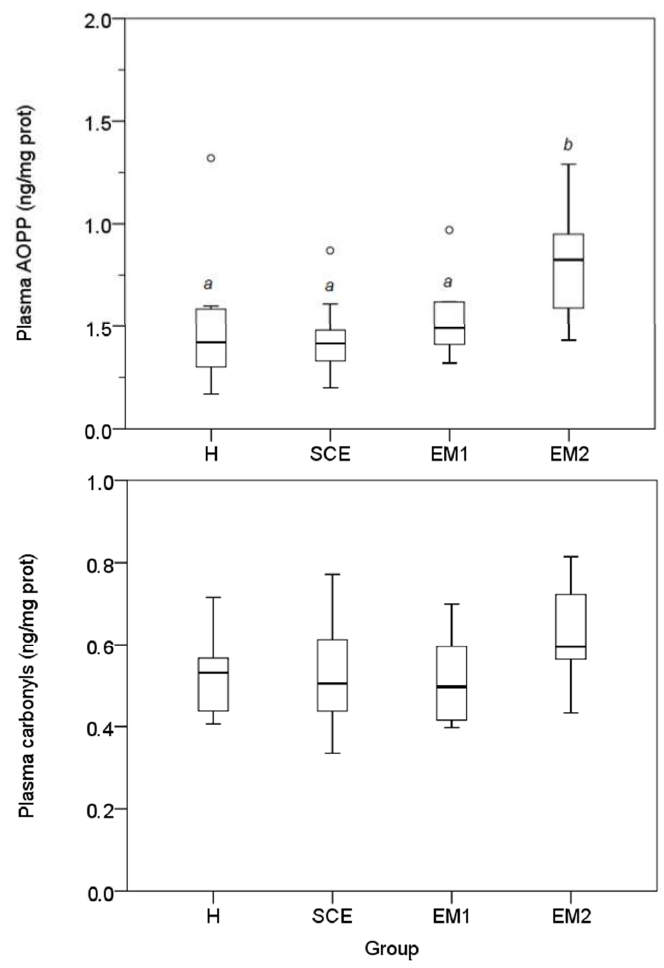
Figure 1. Plasma AOPP and carbonyl group concentrations in the four groups of cows. Different superscripts ( a,b ) indicate statistically significant differences ( p < 0.05; Kruskal-Wallis one-way ANOVA and pairwise multiple comparisons, SPSS 24.0). Healthy cows (H): Clinically healthy subjects with PMN < 5%, one week after the clinical evaluation. (ii) Subclinical Endometritis (SCE): clinically healthy subjects and PMN ≥ 5%, one week after the clinical evaluation. (iii) Grade 1 Endometritis (EM1): Animals clinically diagnosed as EM1 and PMN ≥ 5%, one week after the clinical evaluation.